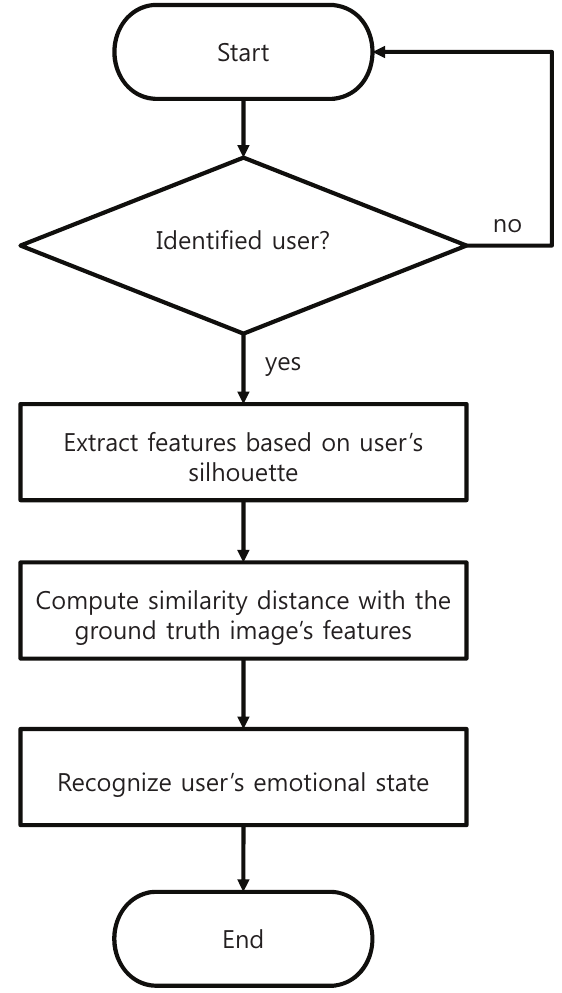
Figure 1. Operation flow of Computerized Emotion Perception based on Posture ( CEPP